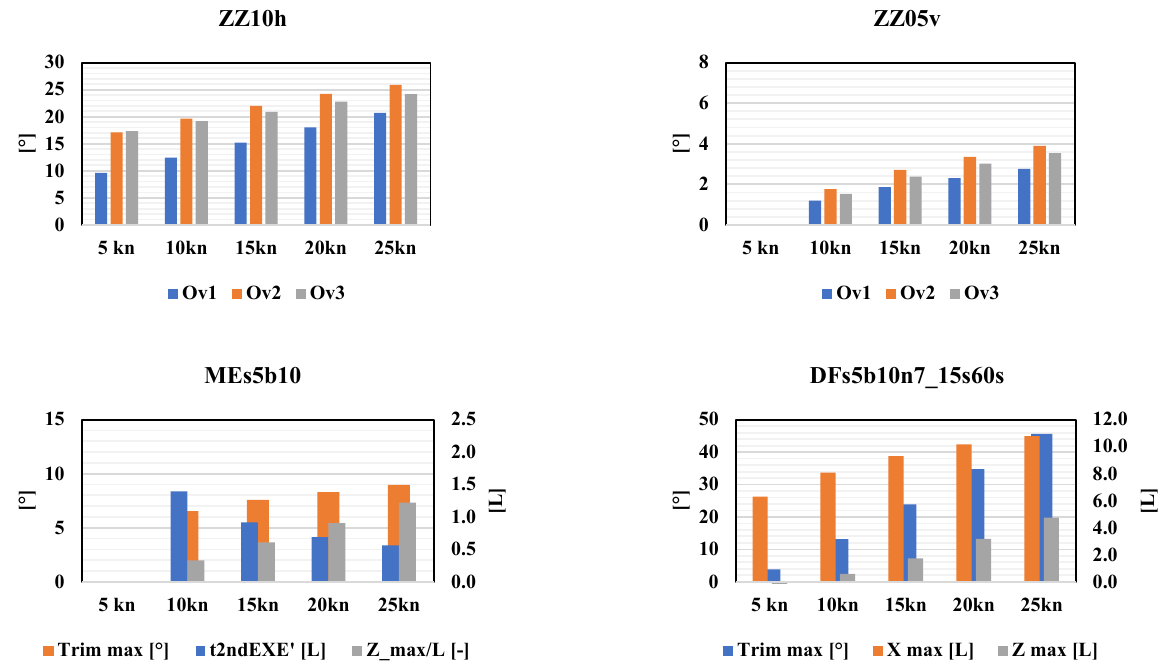
Figure 14. SMG +-Eq—Manoeuvring speed dependency.